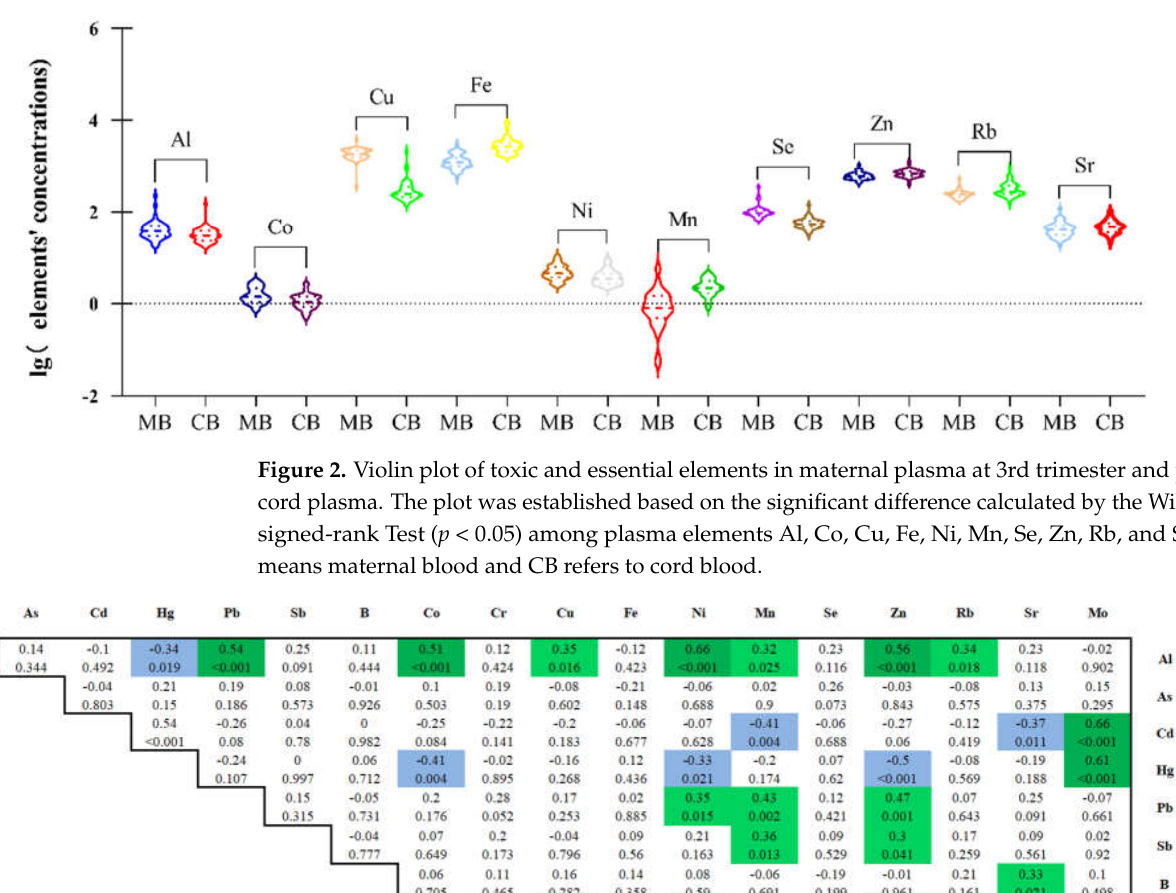
Figure 2. Violin plot of toxic and essential elements in maternal plasma at 3rd trimester and paired cord plasma. The plot was established based on the significant difference calculated by the Wilcoxon signed-rank Test ( p < 0.05) among plasma elements Al, Co, Cu, Fe, Ni, Mn, Se, Zn, Rb, and Sr. MB means maternal blood and CB refers to cord blood.